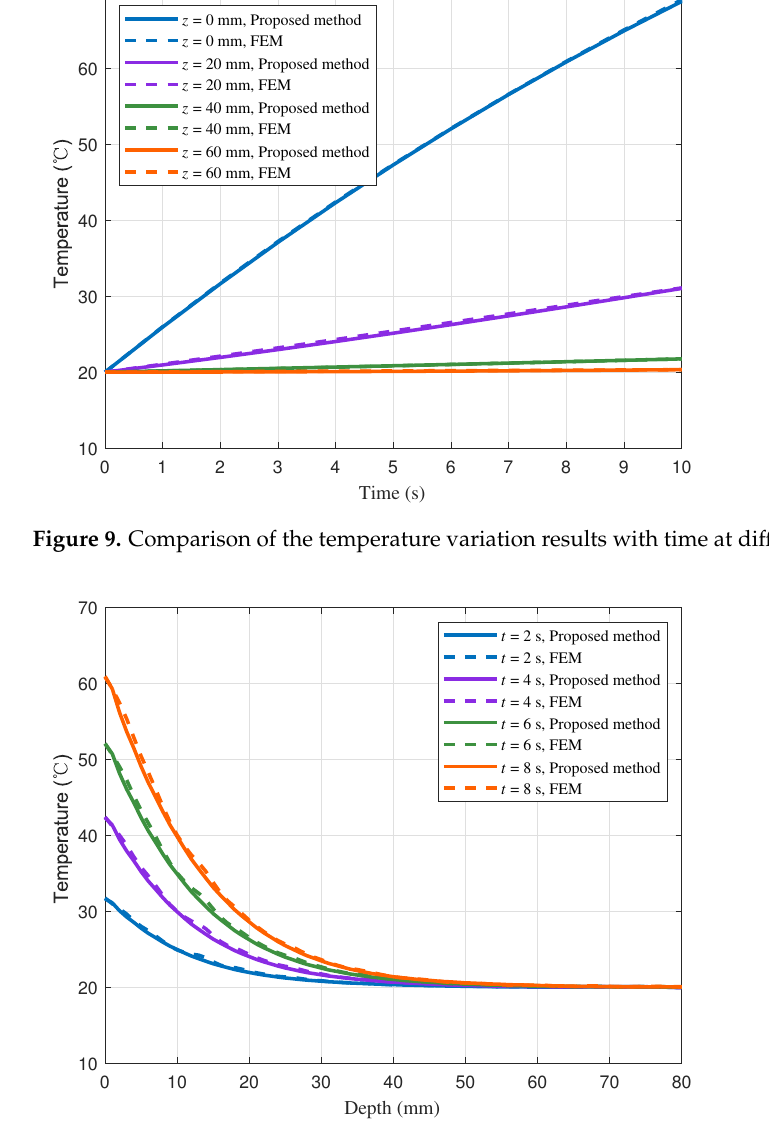
Figure 10. Comparison of the temperature distributions in the z -axis direction at different